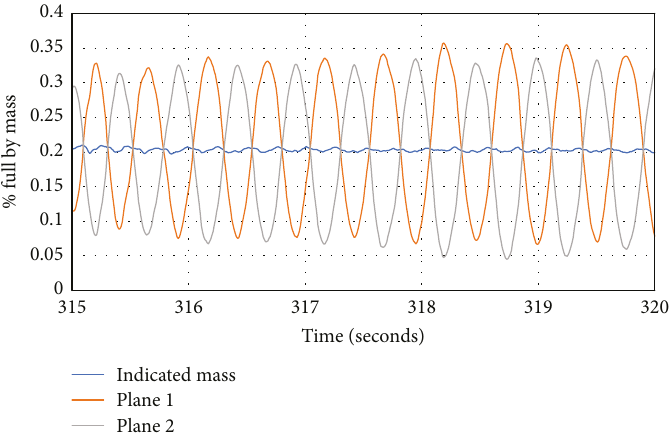
Figure 11: Expanded section of the previous graph.